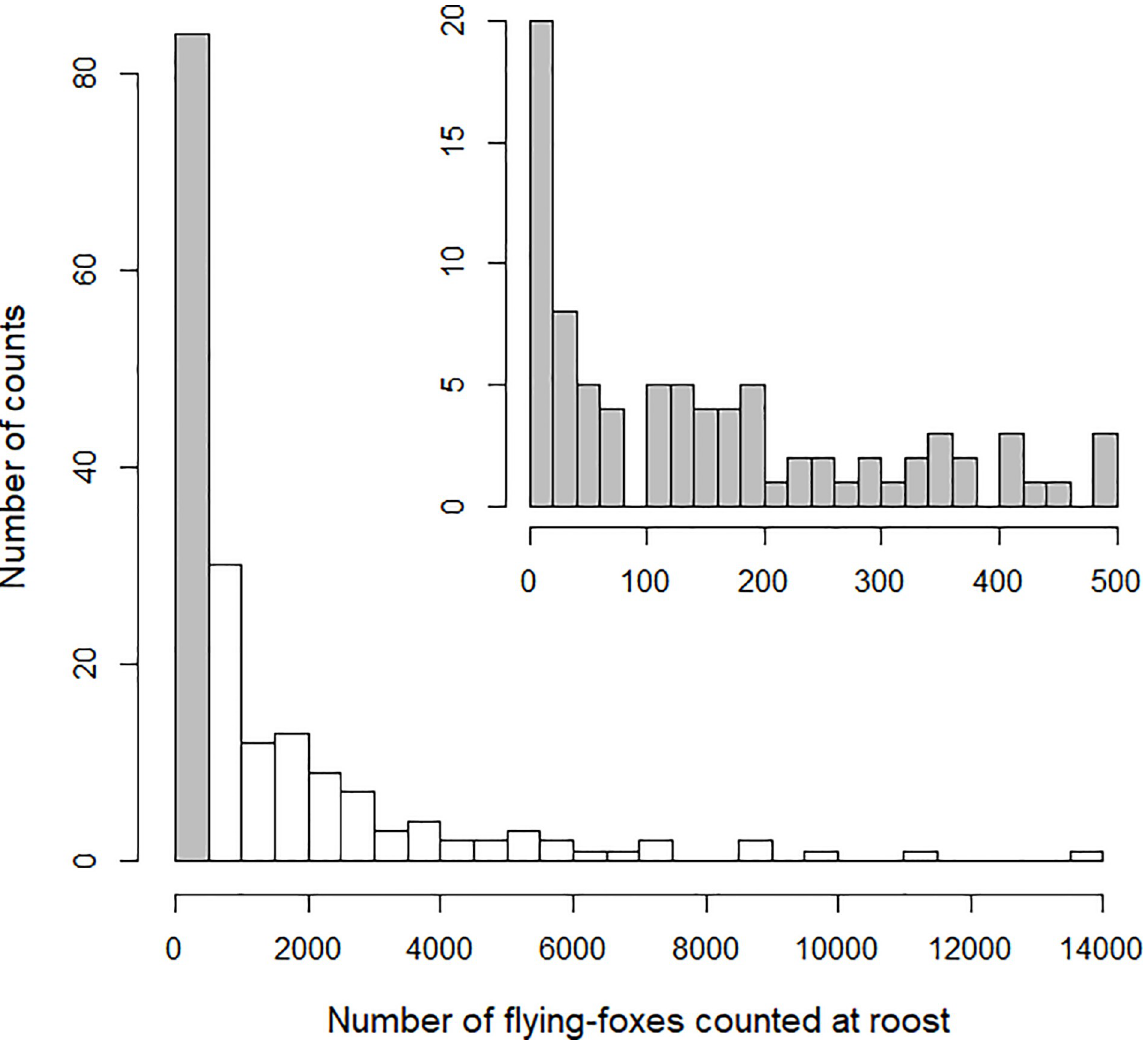
Fig 2. Distribution of the 180 counts made on the sample of 30 flying-foxes roosts of ornate and Pacific flying-foxes in the Northern Province of New Caledonia between 2010 and 2016. Counts of 0 were made in 9 occasions on four different roosts. The inserted histogram further details the distribution of the first interval (0–499 individuals; grey